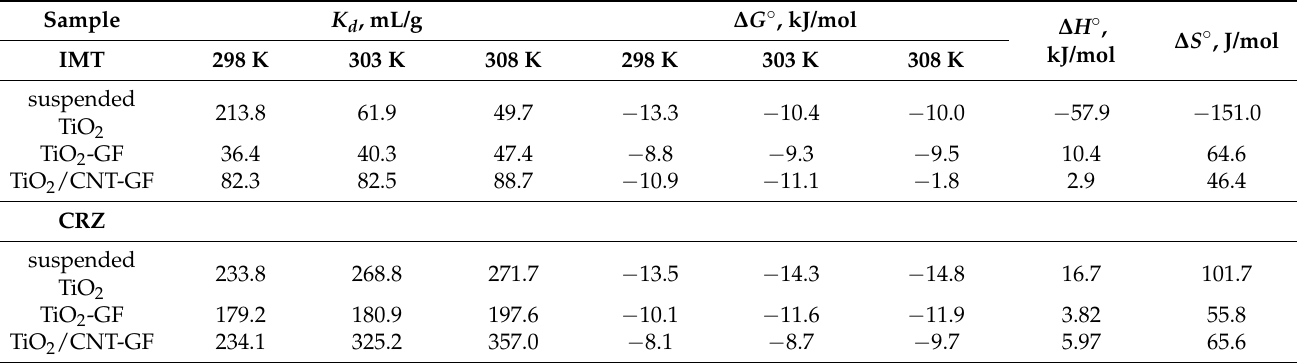
Table 8. Thermodynamic parameters for IMT and CRZ